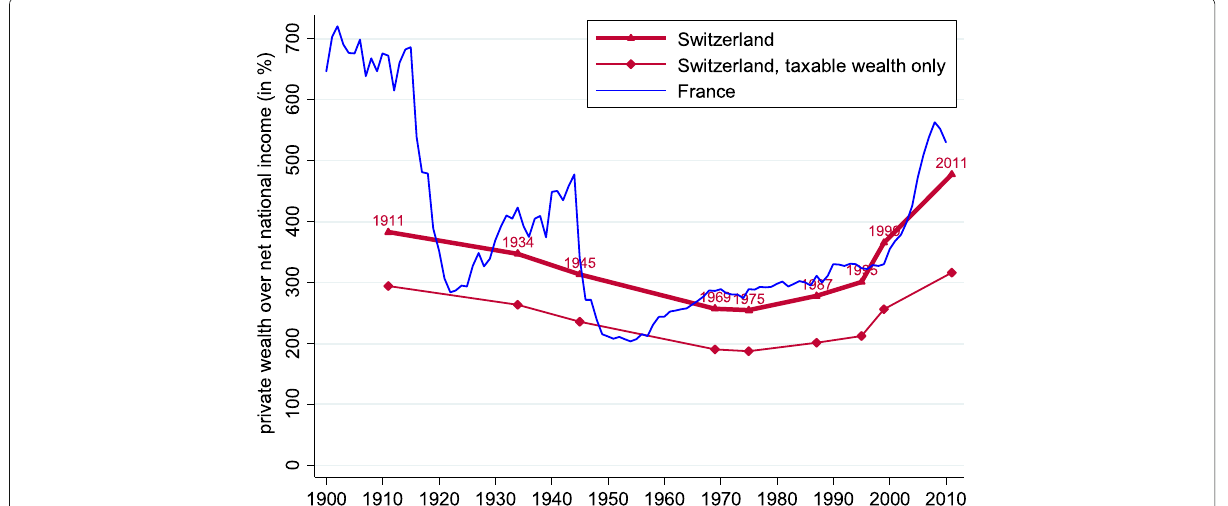
Fig. 4 Private wealth as a fraction of net national income: Switzerland and France. Notes: data for France from Piketty (2011). See text for Swiss data